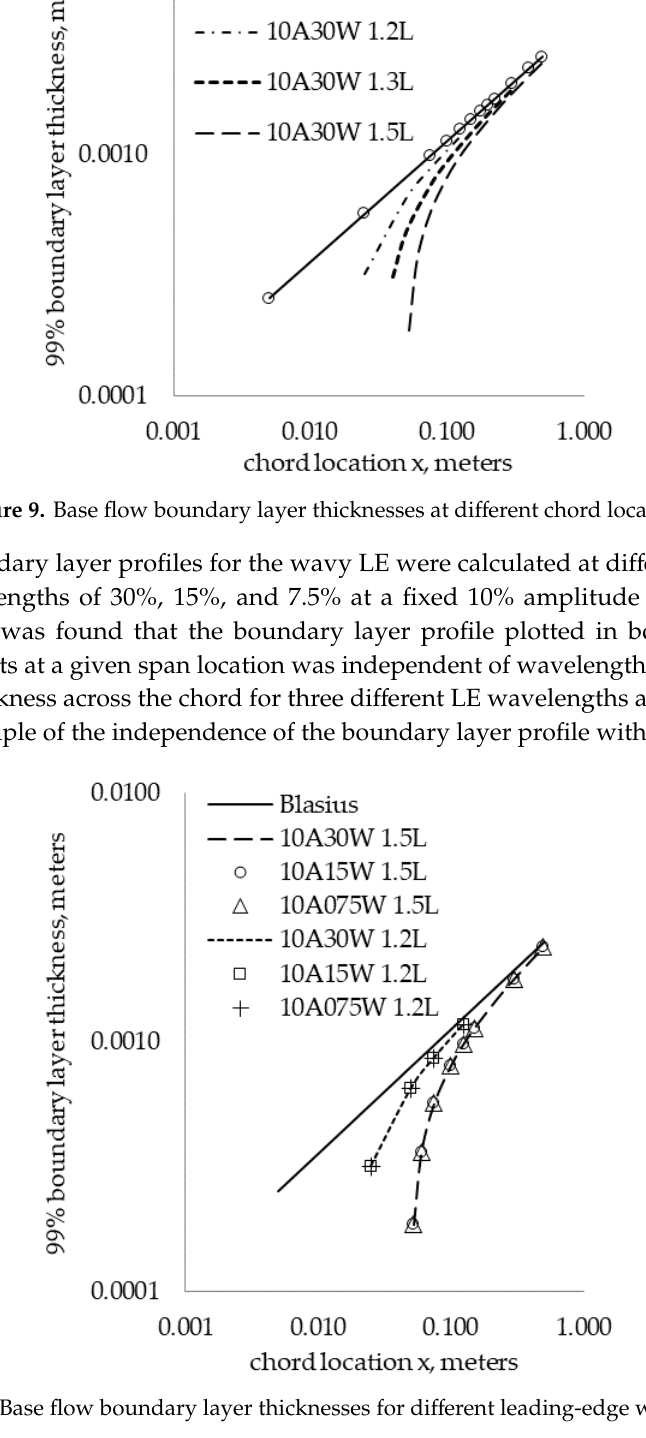
Figure 10. Base flow boundary layer thicknesses for different leading-edge wavelengths.